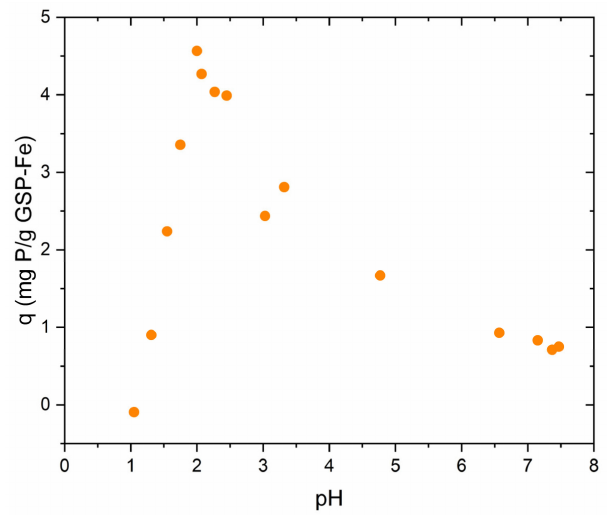
Figure 4. Effect of solution pH on phosphorus adsorption using GSP-Fe S-1. Dose of GSP-Fe S-1 = 2 mg · L − 1 , equal to 47.4 mg · L − 1 of Fe, room temperature and stirring at 175